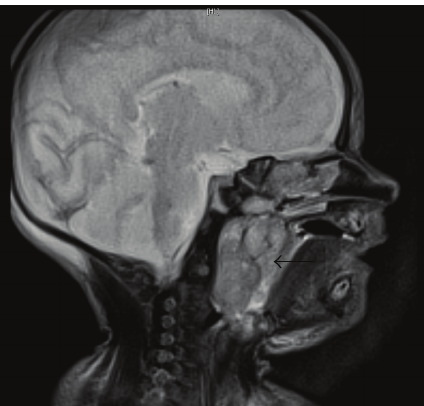
Figure 1: T2 weighted MRI of NPT (sagittal view).